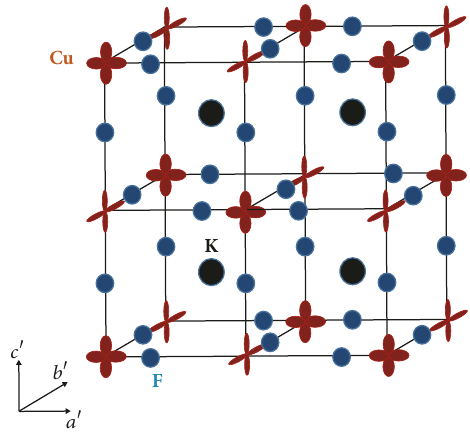
Figure 1: Stick-and-ball representation of KCuF 3 in the P mmm space group (see text for details). For the sake of clarity, only half a cell is shown in the figure (0 ≤ y ≤ 0.5). The shifts of the position of F ions in the ab plane, in respect to the middle of the Cu-Cu internuclear axis as in cubic perovskite, are enlarged to highlight thedeformationofCuF 6 octahedra.Thepartiallyfilledd responsible for orbital ordering are schematicallyrepresentedin red. Table 1: Crystallographic parameters of pure KCuF3 in the AF1 magnetic phase (I4/ mcm space